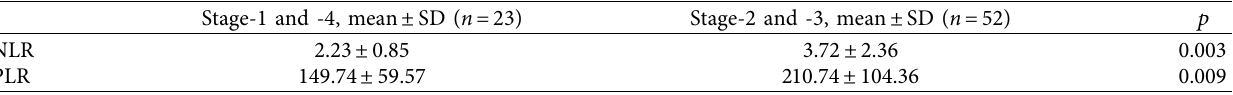
Table 3: The comparison of NLR and PLR between sarcoidosis patients at stage-1 and -4 and stage-2 and -3. Stage-1 and -4, mean ± SD ( n � 23)